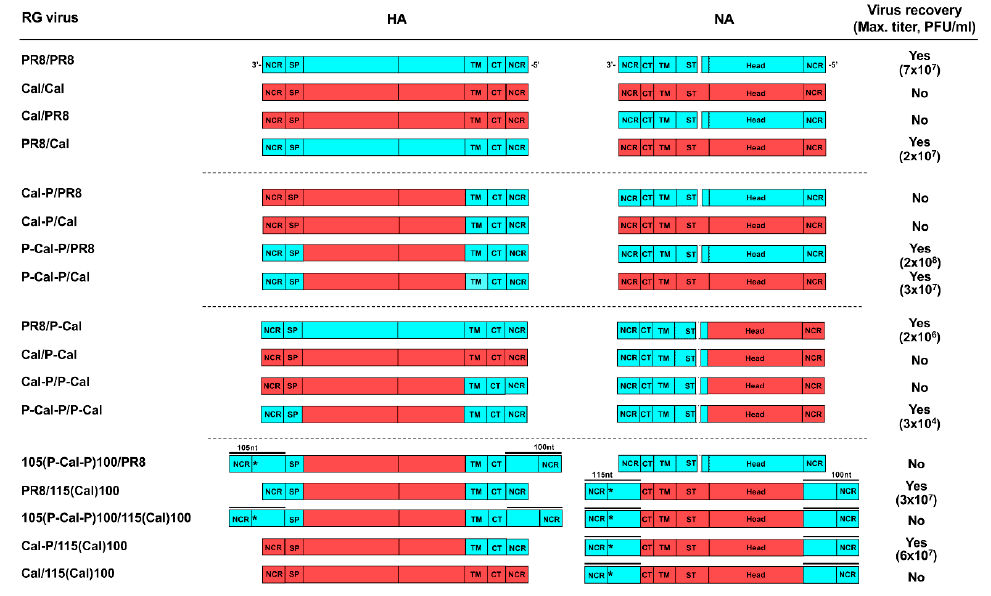
Figure 2. Schematic diagram of RG viruses with chimeric HA and NA segments. Nucleotide sequences derived from PR8 are shown as light blue boxes and sequences from Cal are shown as red boxes. Designations of RG viruses are shown to the left of constructs. For some RG viruses, the 3 ′ - and 5 ′ -terminal sequences (100–115 nt) were added to the coding region (including the start codon and the stop codon) and are shown with overlines. The start codon present in the added regions was substituted with a stop codon (shown with asterisks). NCR—non-coding region; SP—signal peptide; TM—transmembrane; CT—cytoplasmic tail. Recovery of RG viruses was performed in MDCK-SIAT1 cells.